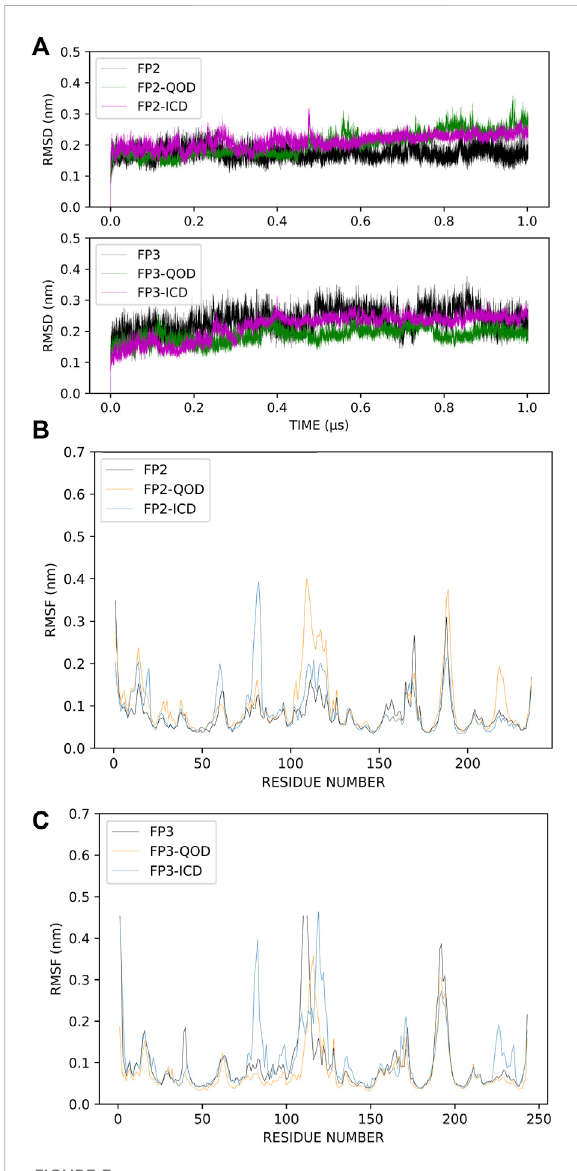
Root-mean-square deviations (RMSD) of the protein backbone atoms of the different simulation systems. Apo-FP2/ FP3, FP2/FP3-QOD, FP2/FP3-ICD are represented in black, green and magenta lines, respectively. (A) . Root-mean-square fl uctuations(RMSF)ofC- α atomsofFP-2simulationsystems.Apo- FP2,FP2-QOD,FP2-ICDarerepresentedinblack,orangeandlight blue lines, respectively. (B) . Root-mean-square fl uctuations (RMSF) of C- α atoms of FP-3 simulation systems. Apo-FP3, FP3- QOD, FP3-ICD are represented in black, orange and light blue lines, respectively. (C)